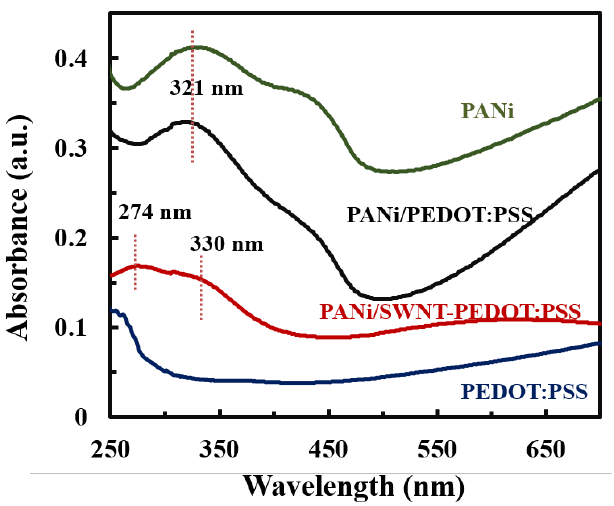
Figure 5. UV–vis spectra of aqueous PANi, PEDOT:PSS, PANi/PEDOT:PSS, and PANi/SWNT- Figure 5. UV – vis spectra of aqueous PANi, PEDOT:PSS, PANi/PEDOT:PSS, and PANi/SWNT-PE- PEDOT:PSS thin DOT:PSS thin films.